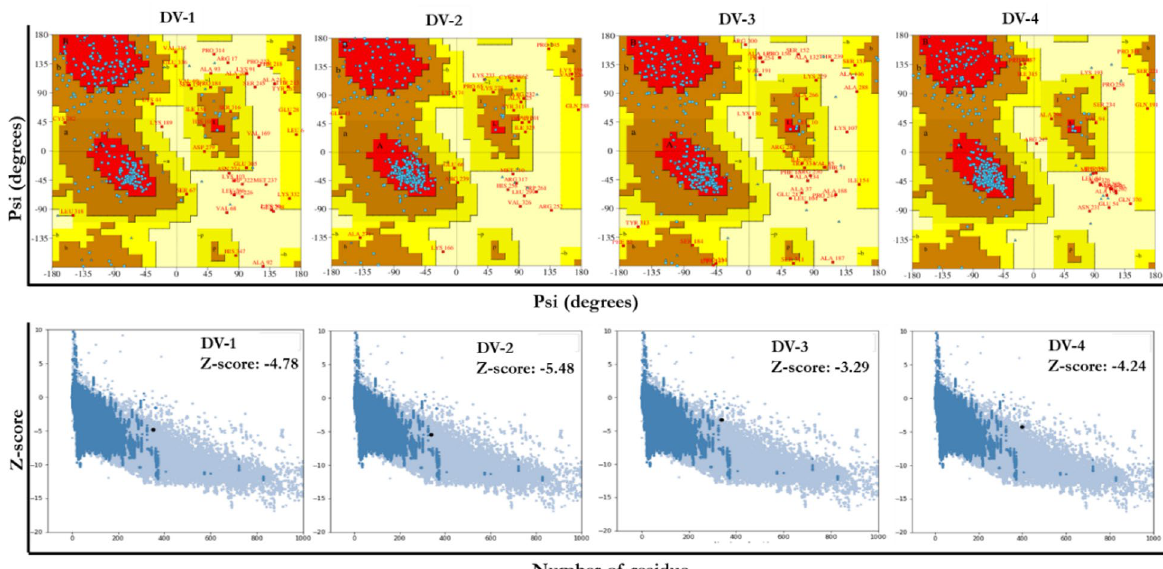
Figure 4. Validation of the modeled-predicted DENV vaccines with